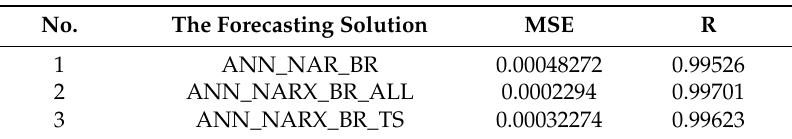
Table 5. The relevant parameters of the ANN_NAR_BR, ANN_NARX_BR_ALL and ANN_NARX_BR_TS forecasting